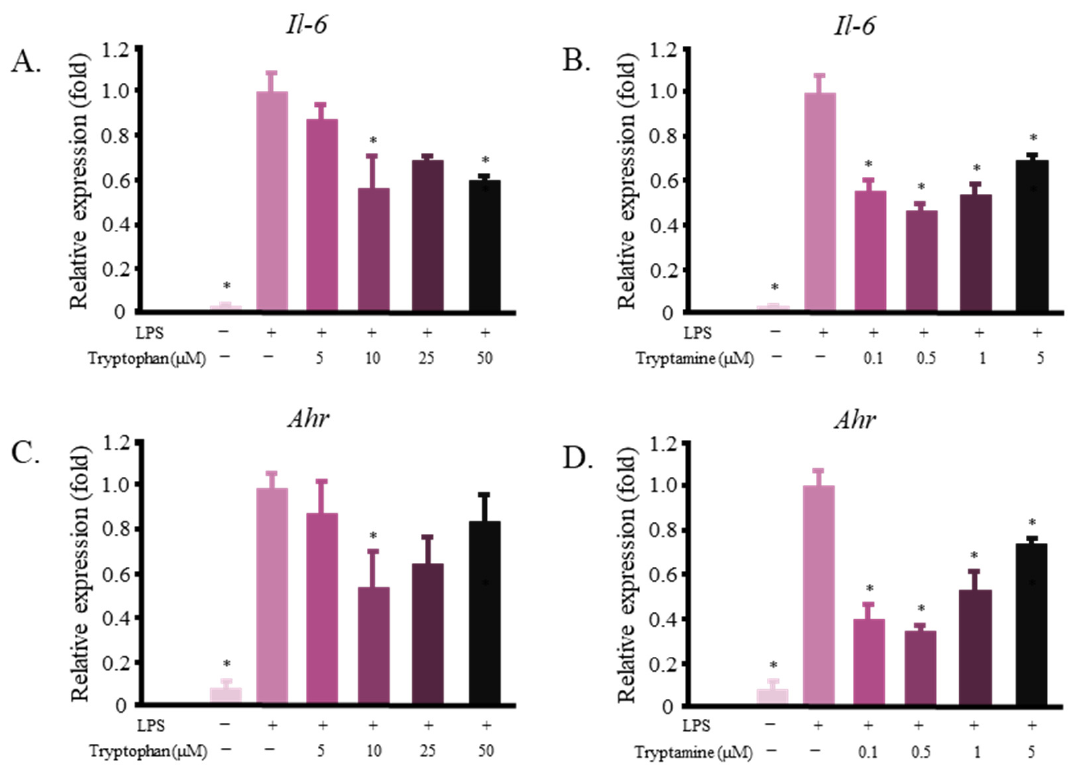
Figure 5. Tryptophan and its microbial metabolites affect the expression of Il-6 and Ahr in LPS- activated RAW 264.7 cells. ( A ) Tryptophan decreased the mRNA level of Il-6 ; ( B ) Tryptamine decreased the expression of Il-6 ; ( C , D ) Tryptophan and tryptamine lowered the level of Ahr . The data are presented as mean values, with error bars representing the standard errors, n = 3. The data were evaluated against the LPS group (Dunnett’s analysis, * p < 0.05).